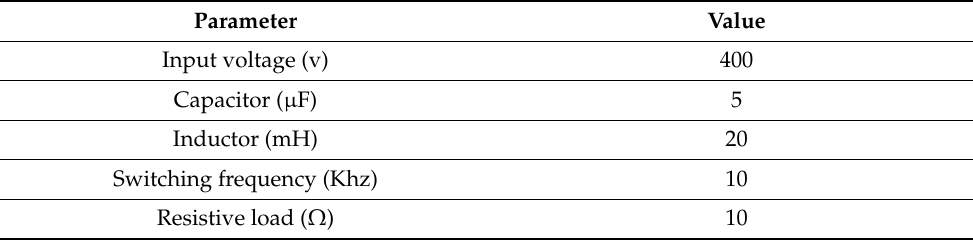
Table 1. DC-DC buck converter